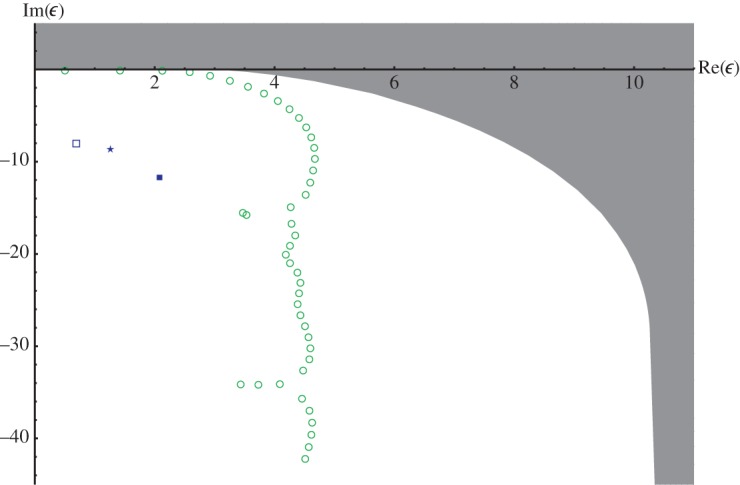
Resonance-free region in theorem 2.1 (grey-shaded), approximate resonance strings of Rittby et al. (circles) and Abramov et al. (squares and star). (Online version in colour.)